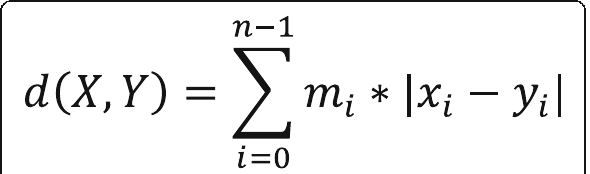
Fig. 3 Manhattan distance calculation with a feature